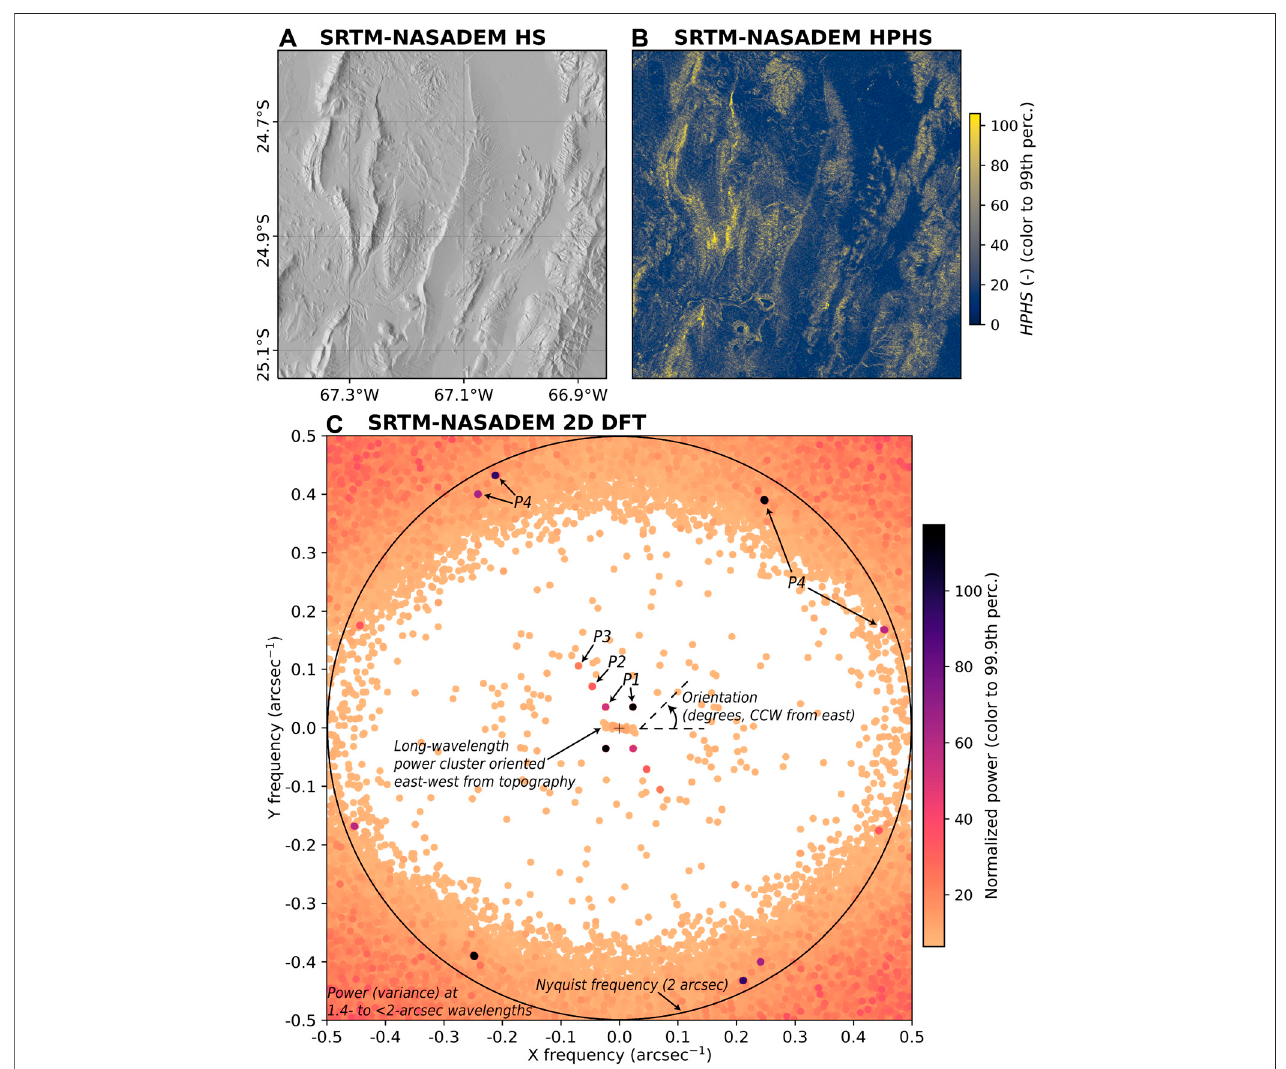
FIGURE4| Exampleofa2DDFTanalysisof HPHS ina ∼ 60-kmsquaretileforanun-projected1 arcsecDEM. (A) SRTM-NASADEMhillshade. (B) HPHS calculated on the tile, with color scaled from 0 to the 99th percentile. Note the distinct NW-SE striping pattern, particularly in the northwest. (C) 2D DFT periodogram, showing the normalized amplitude (power) in frequency space. The lowest frequencies (longest wavelengths) are in the center of the plot, and wavelength (frequency) decreases (increases)awayfromthecenter.Anytwoadjacentquadrantsintheplotcontainalltheinformation,whichisre fl ected throughthecentralorigin. Theassociated1D DFT is shown in Figure 5 . For visualization purposes, the periodogram was morphologically dilated to increase the size of the discrete, high-power peaks and values below the 50th percentile were excluded (colored white). Note the peaks (P1 – 4) orientated at ∼ 120 ° (counter clockwise (CCW) from east), with P4 ( ∼ 60 m wavelength) occurringatotherorientations.Thesignalofnorth-southorientatedtopographycanbeseeninthediffuseeast-westpowerclusteratthelowestfrequencies,andthehigh power (high variance) above the Nyquist frequency (black circle) is shown by the high values in the corners.